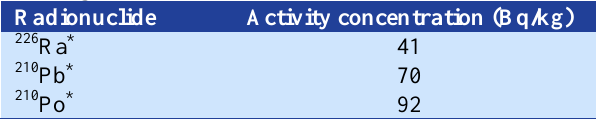
Table 3. Proposed clearance levels for